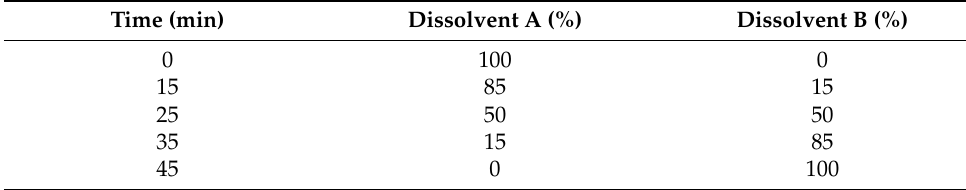
Table 4. Gradient elution and time program for